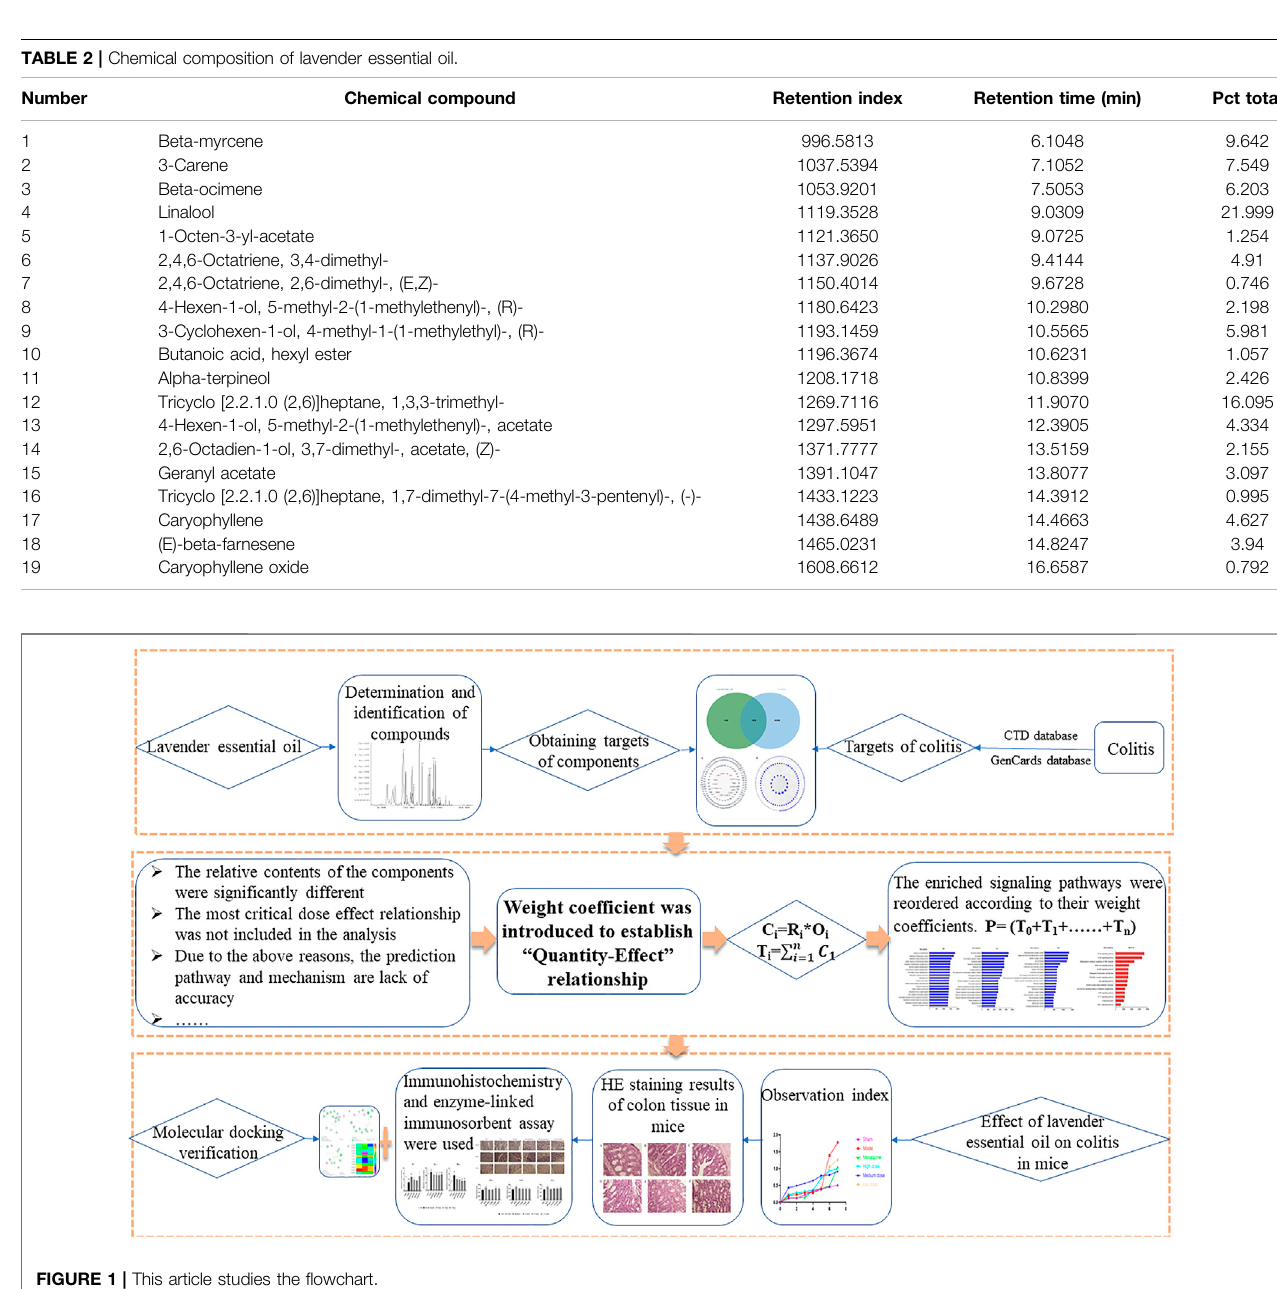
FIGURE 1 | This article studies the fl owchart.